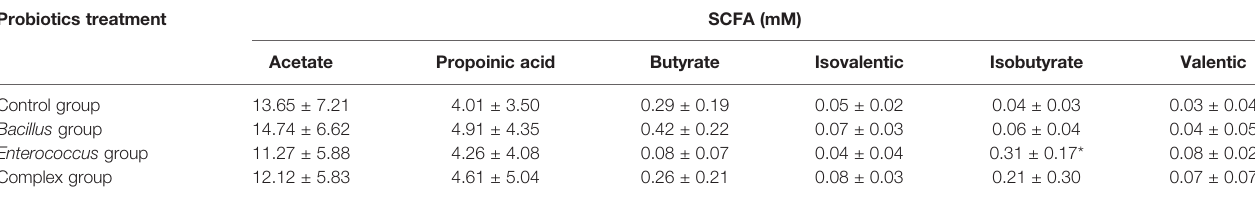
TABLE 3 | Short-chain fatty acid (SCFA) concentration of different probiotic treatments after 24 h fermentation. Probiotics